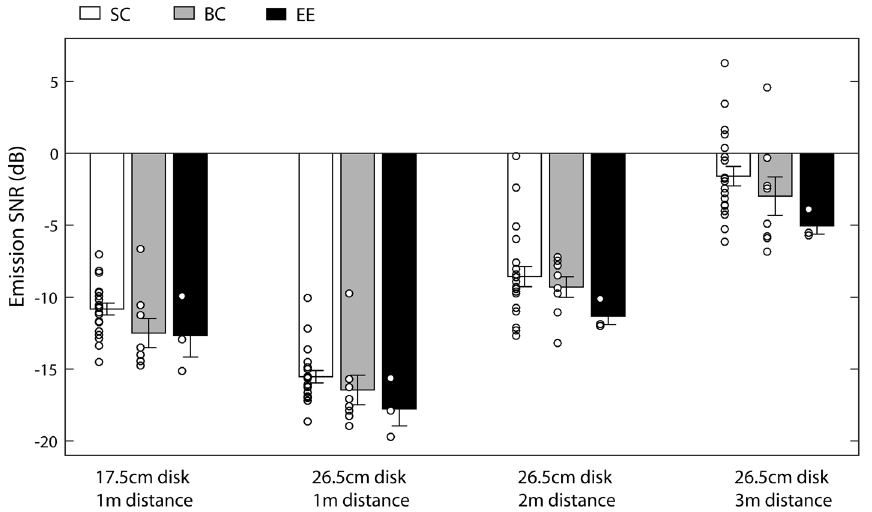
Figure 5. Emission SNRs for the different conditions and participant groups (SC – sighted controls; BC – blind controls; EE – expert echolocators). Bars represent means and error bars represent standard error of the mean across participants. Circles represent individual